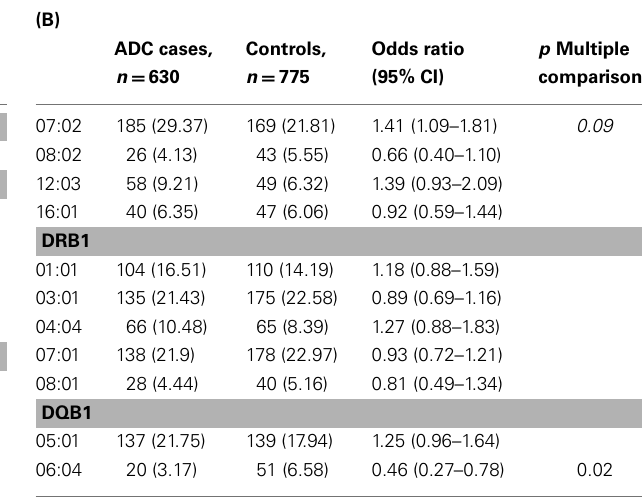
Table 1 |Association between 11 a priori selected HLA alleles (A), and remaining 38 non a priori HLA alleles (B) and cervical adenocarcinoma (ADC) among Caucasians, PooledWestern and Eastern US cervical cancer studies .